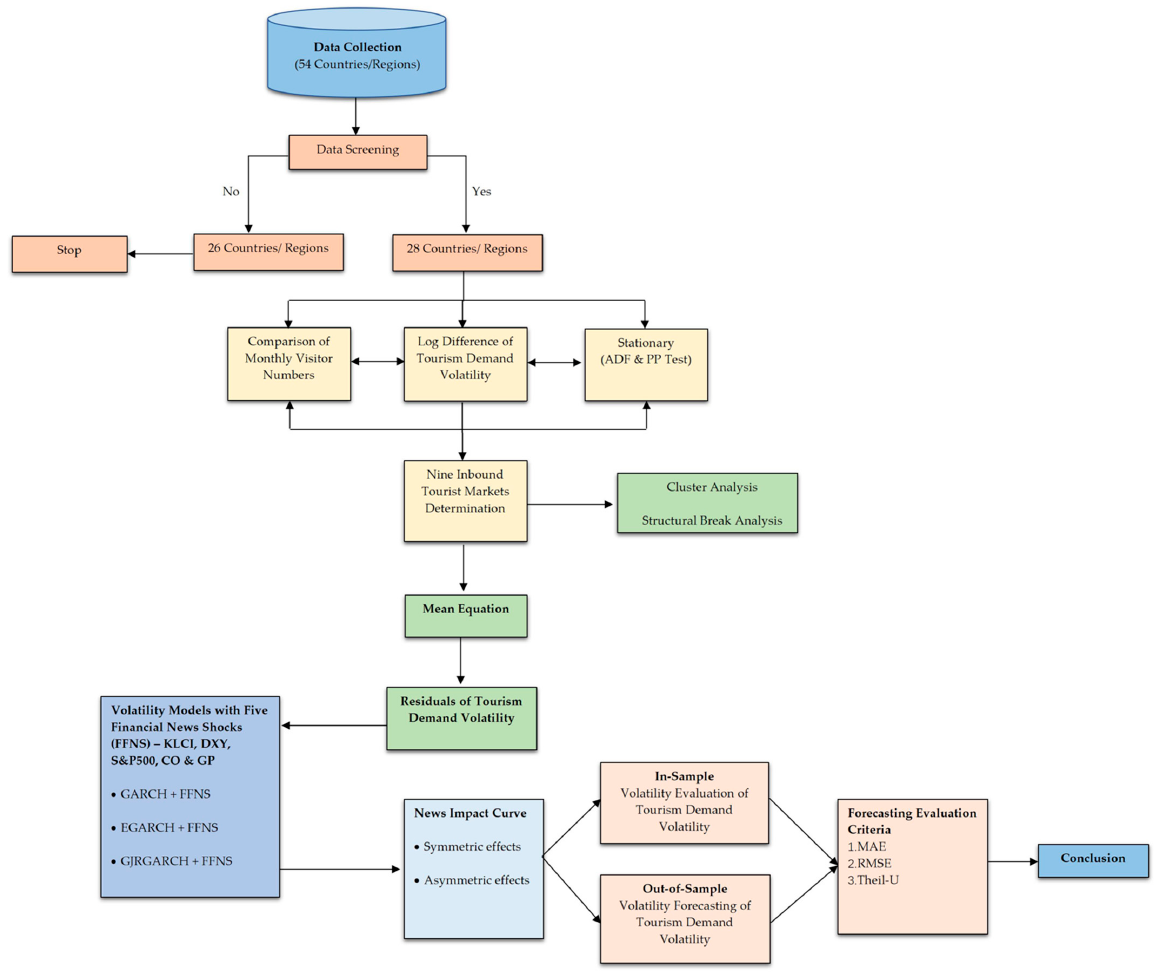
Figure 3. Research Framework.